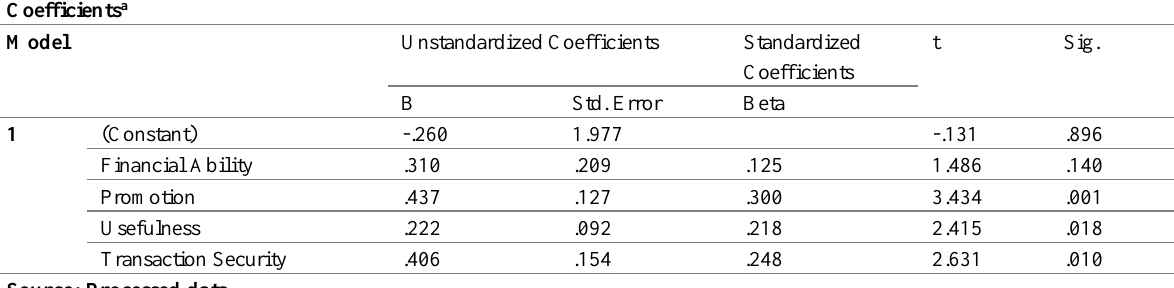
Table 12: T Test Results